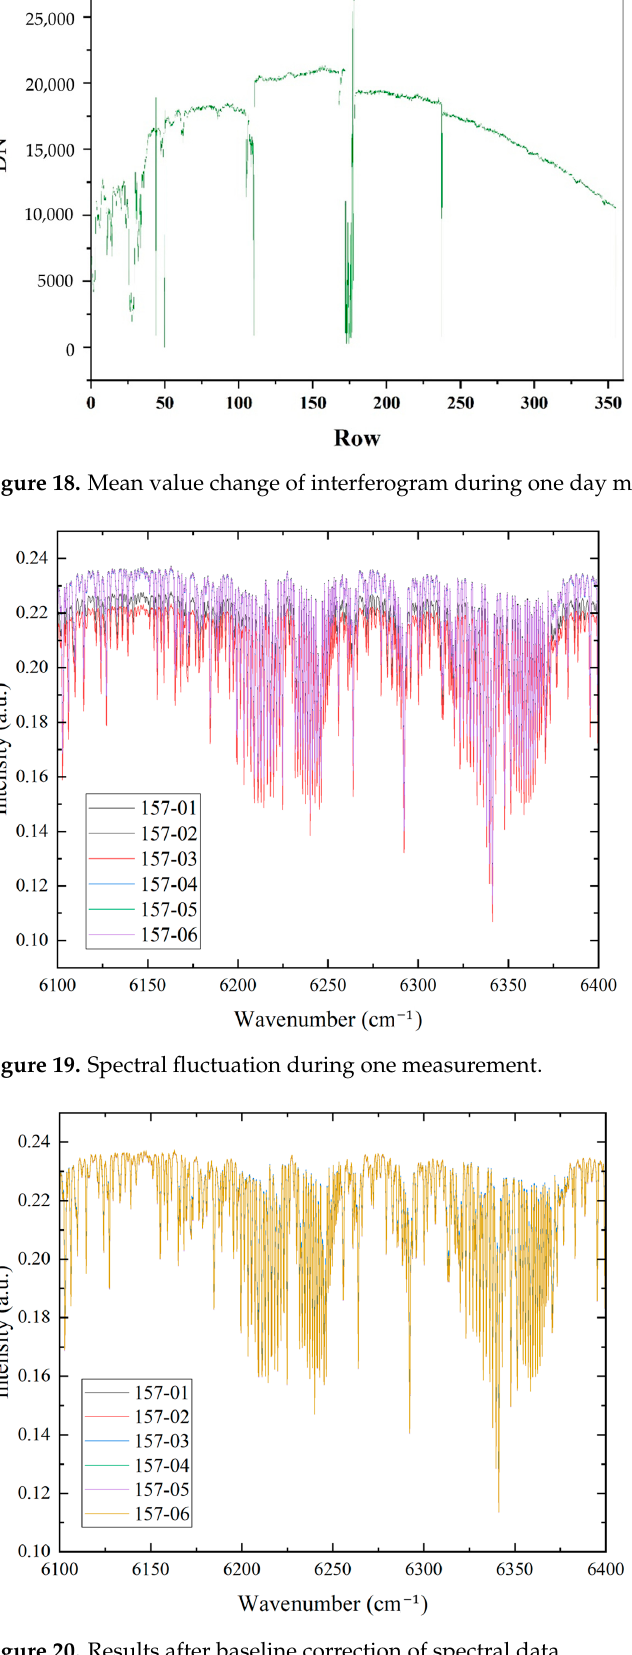
Figure 18. Mean value change of interferogram during one day measurement.